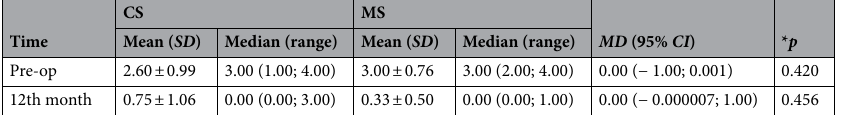
Table 3. Statistical characteristics of the number of glaucoma therapies (means, medians, standard deviations, and ranges) in the CS and MS groups at specific timepoints post-surgery. CS corneal suture group, MS muscle suture group, SD standard deviation, Pre-op pre-operatively, MD median difference calculated as the result for the CS group minus the result for the MS group with the 95% confidence interval (CI). *Mann–Whitney U test.